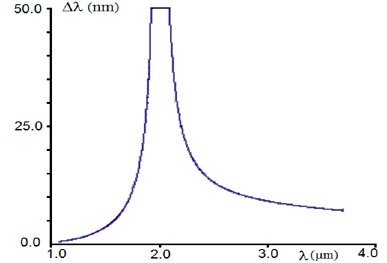
Figure 5. Dependence of spectral width versus wavelength for SHG in xy plane.